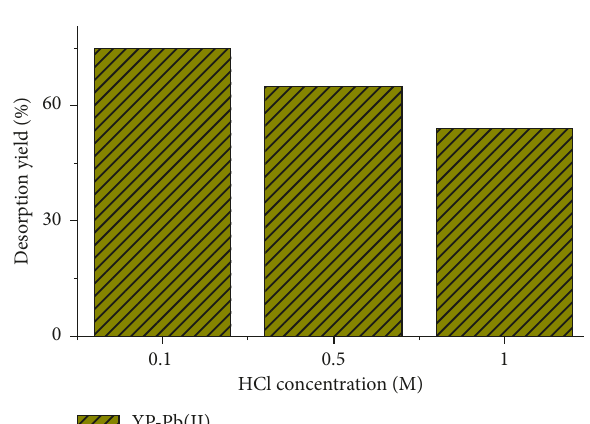
Figure 7: Effect of hydrochloric acid concentration on desorption